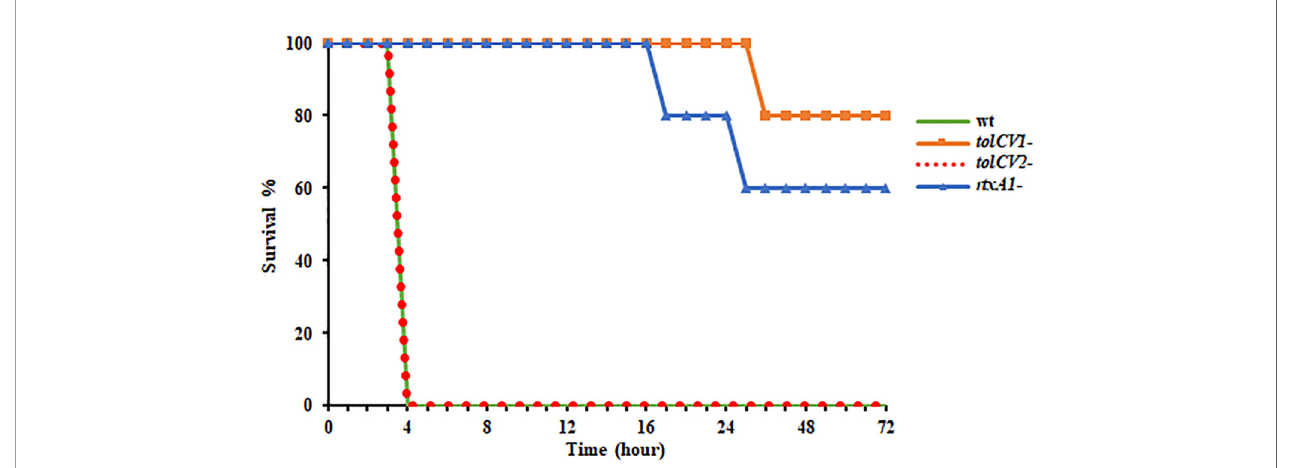
FIGURE 5 | Effect of tolCV1 or tolCV2 mutation on mice lethality caused by V. vulni fi cus . Eight-week-old female ICR mice were infected with V. vulni fi cus wild-type (wt), tolCV1 mutant ( tolCV1 -), tolCV2 mutant ( tolCV2 -), or rtxA1 mutant ( rtxA1 -) strains (1×10 7 CFU/mouse) via intraperitoneal injection. Infected mice were observed for 72 h after injection and their survival times were recorded. Five mice were tested for each